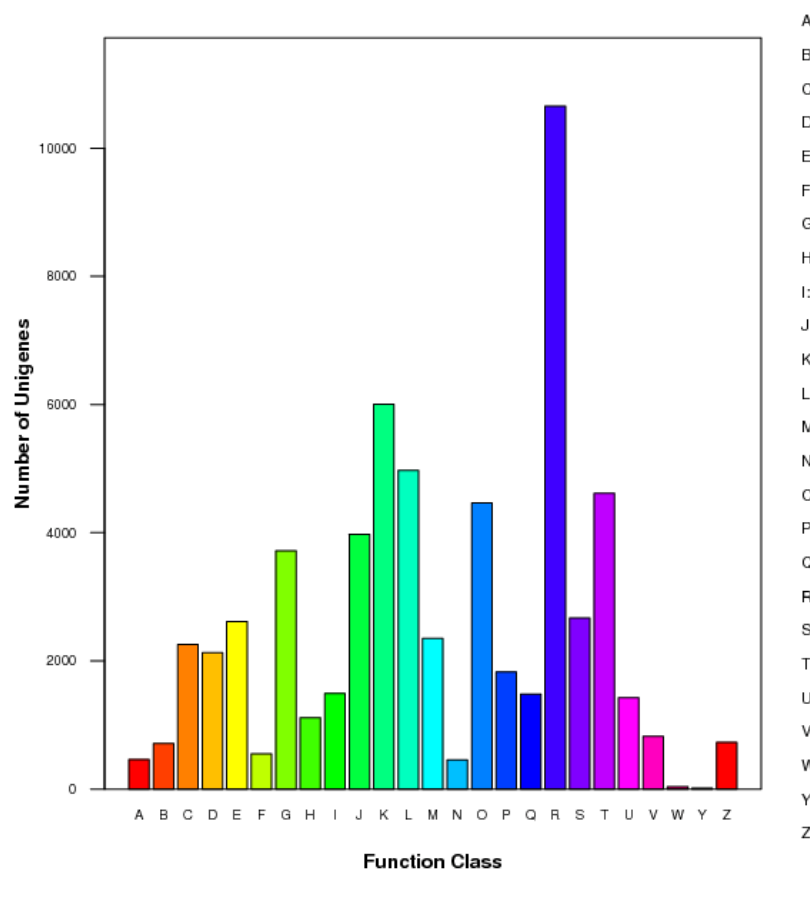
Figure 4. Classification of the clusters of orthologous groups (COG) for the transcriptome of P. australis . 31,550 unigenes (8.26% of the total) were annotated and divided into 25 specific